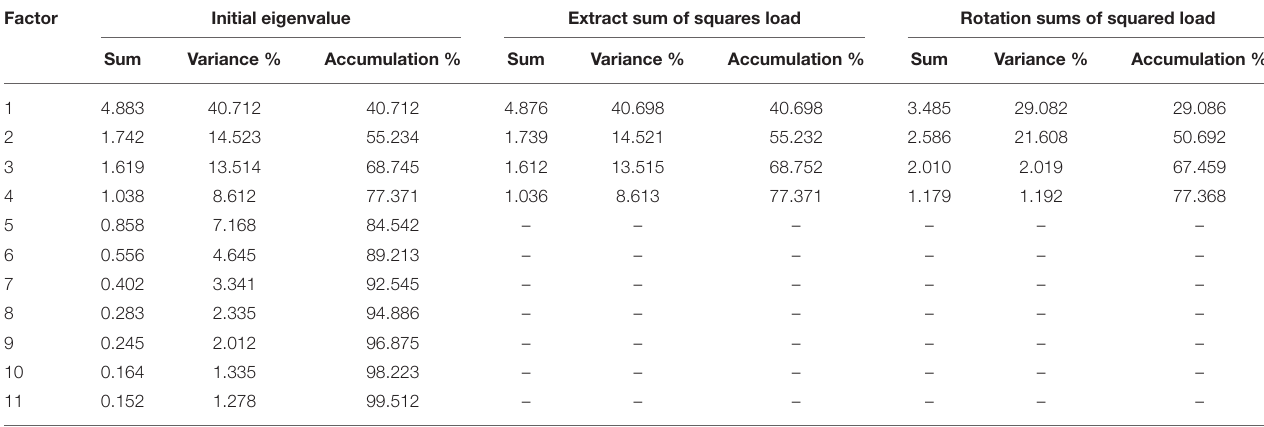
TABLE 8 | Factor analysis explained the total variance.